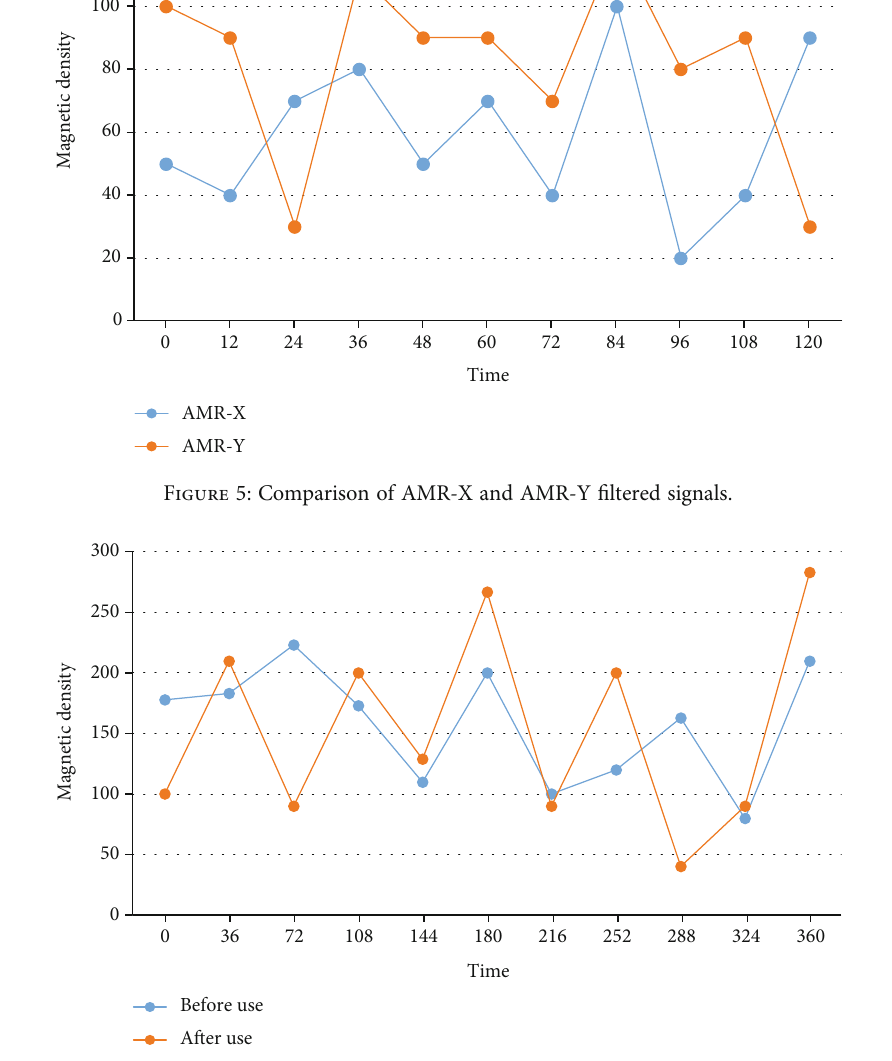
Figure 6: Waveform changes of a driving vehicle before and after using 3D target detection